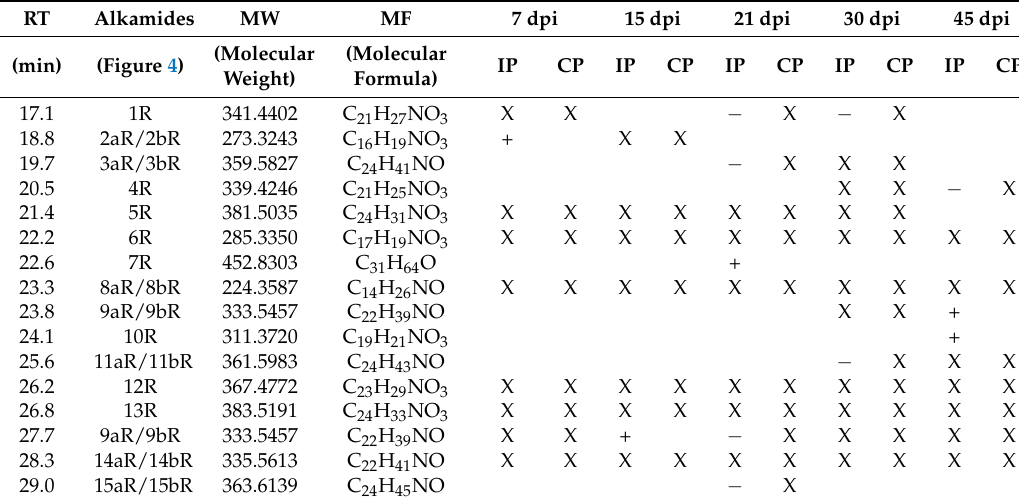
Table 3. Chemical profile of root extracts of Bragantina cultivar: inoculated plants (IP) and control plants (CP).